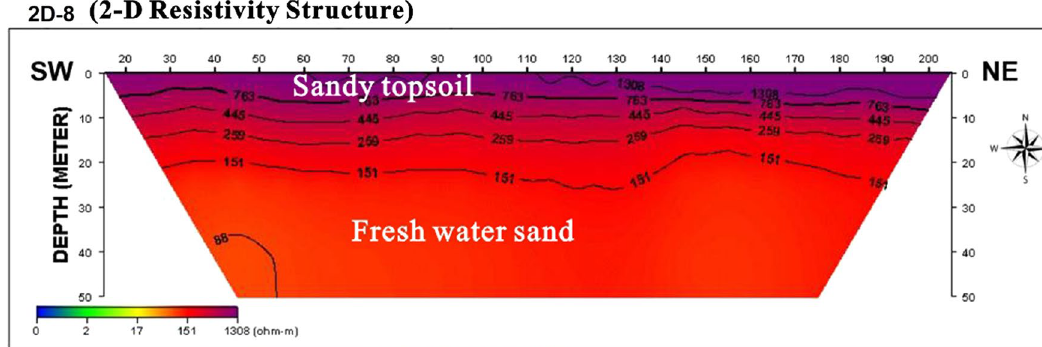
Fig. 12 Resistivity imaging of Traverse 2D-8